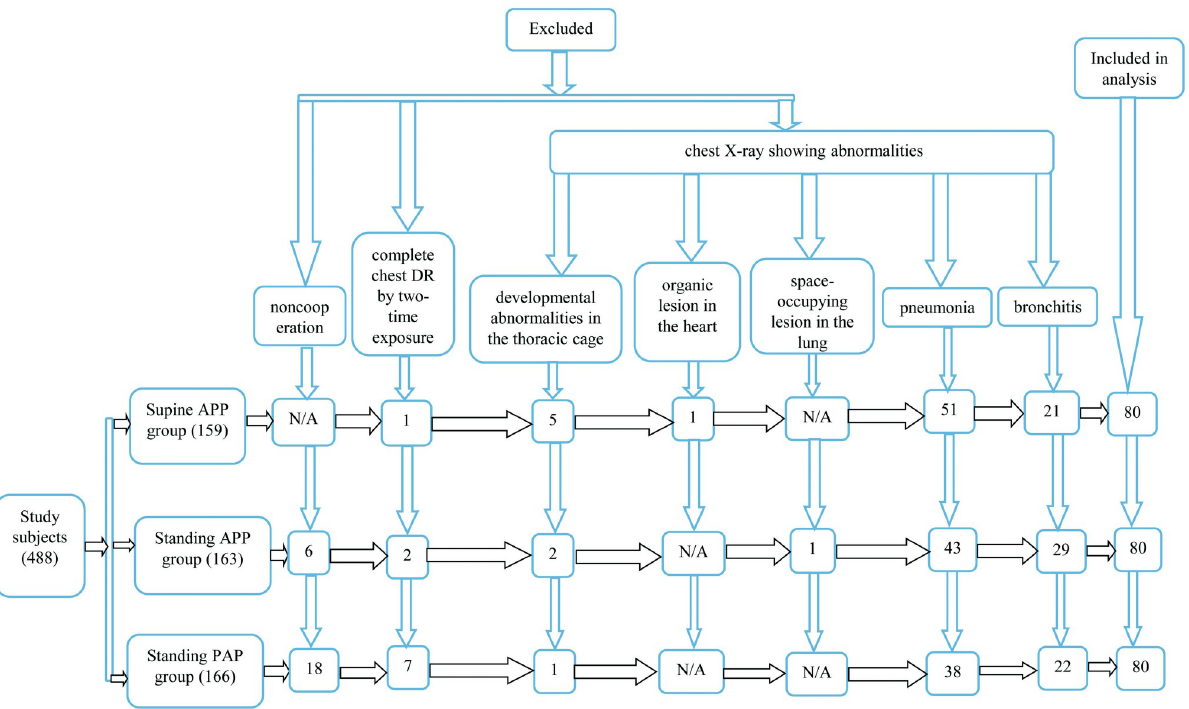
Fig 1. Study design flow chart. The numbers in parentheses in the boxes in the first two columns indicate the number of children who underwent chest X-ray radiography. The numbers in the boxes in the remaining eight columns indicate the number of children who were excluded or included. N/ A indicates “not